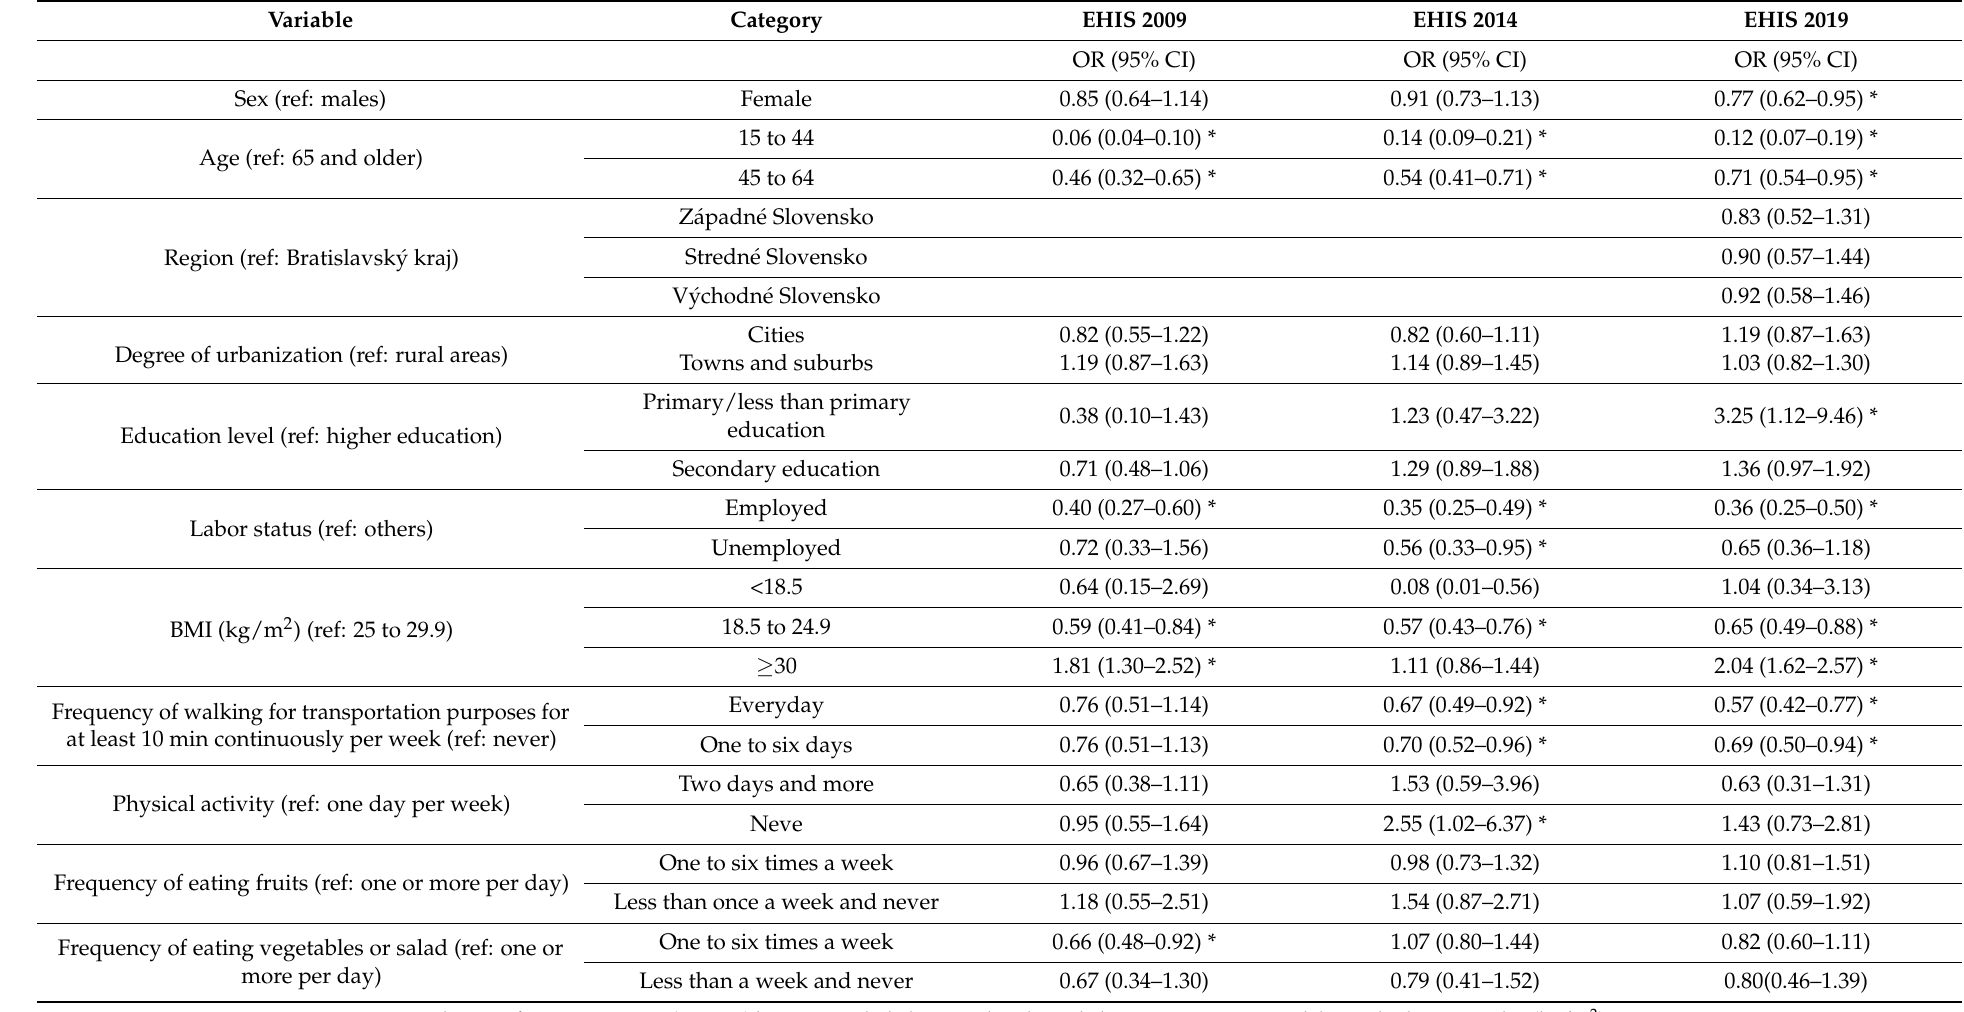
Table 2. Factors associated with diabetes